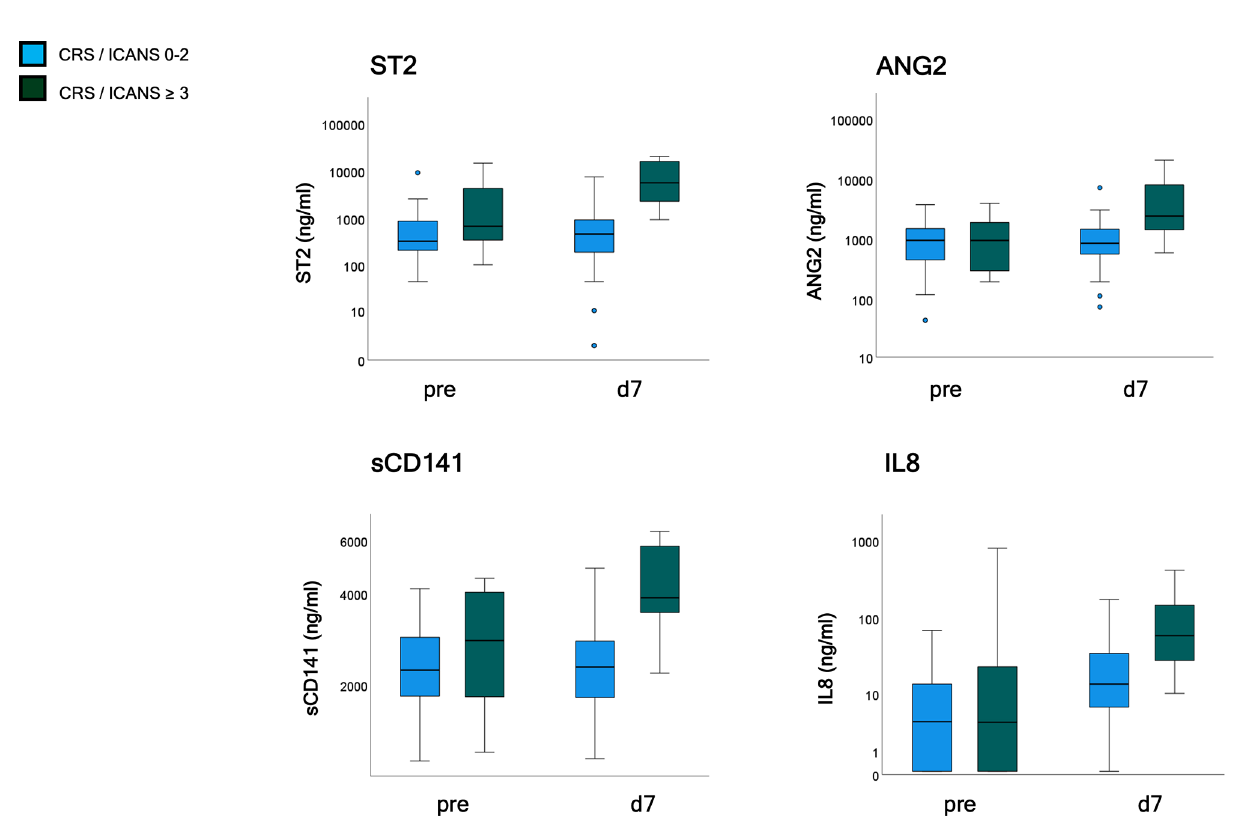
FIGURE 4 | Endothelial serum marker kinetics (validation cohort, n = 47). Patients were grouped according to CRS and ICANS grade with analysis of endothelial markers (ST2, ANG2, sCD141, and IL8) prior to lymphodepletion and on day 7 after application. CRS and/or ICANS grades 0-2 ( n = 39) and ≥ 3 ( n = 8). EASIX, Endothelial Activation and Stress Index; ST2, suppressor of tumorigenicity 2; ANG2, Angiopoietin-2; sCD141, soluble thrombomodulin; IL8, interleukin 8; pre, prior lymphodepletion; d,